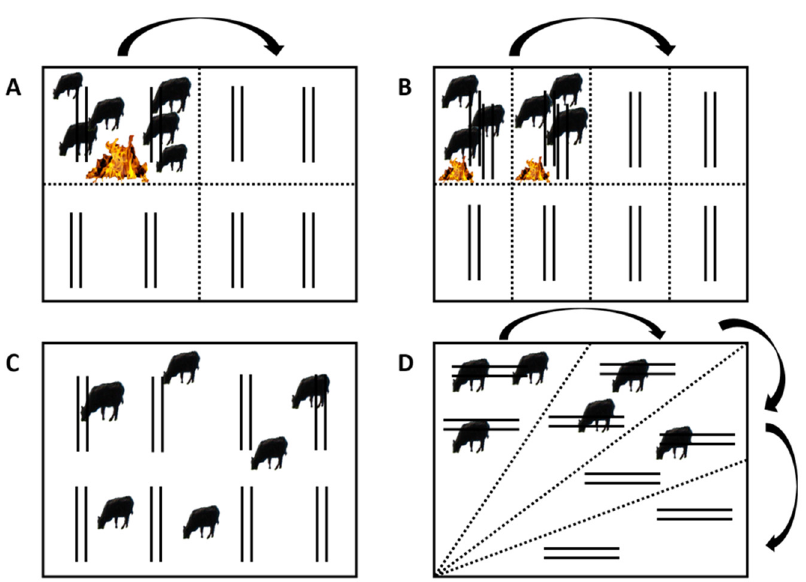
Figure A2. Depiction of ( A ) PBG1; ( B ) PBG2; ( C ) continuous; and ( D ) modified rotational treatments. Dotted lines indicate burn patch boundaries in PBG1 and PBG2 treatments, and the location of interior fencing in modified rotational treatments. Solid interior lines denote vegetation sampling transects. Arrows denote the rotation of burning from year to year in PBG1 and PBG2 treatments, and the rotation of stocking density in modified rotational treatments.